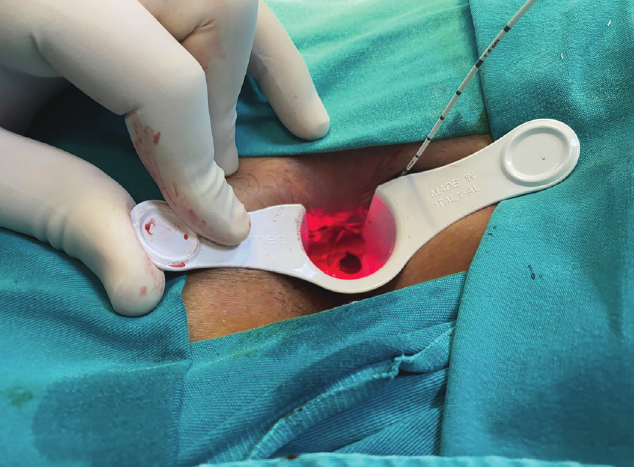
Figure 1 - Treatment of the fistula tract with laser ablation in high anal